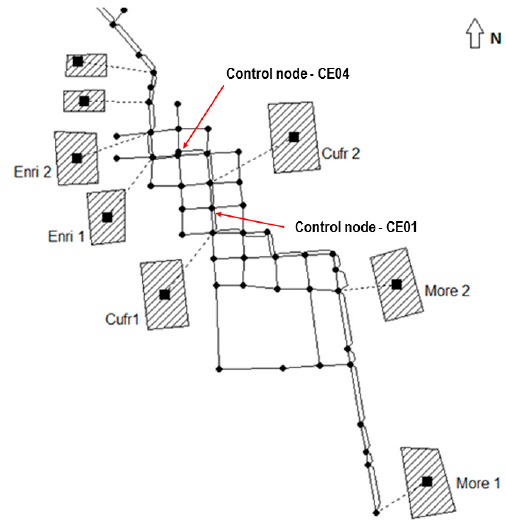
Figure 6 . Representation of sub-catchments in Storm Water Management Model (SWMM).